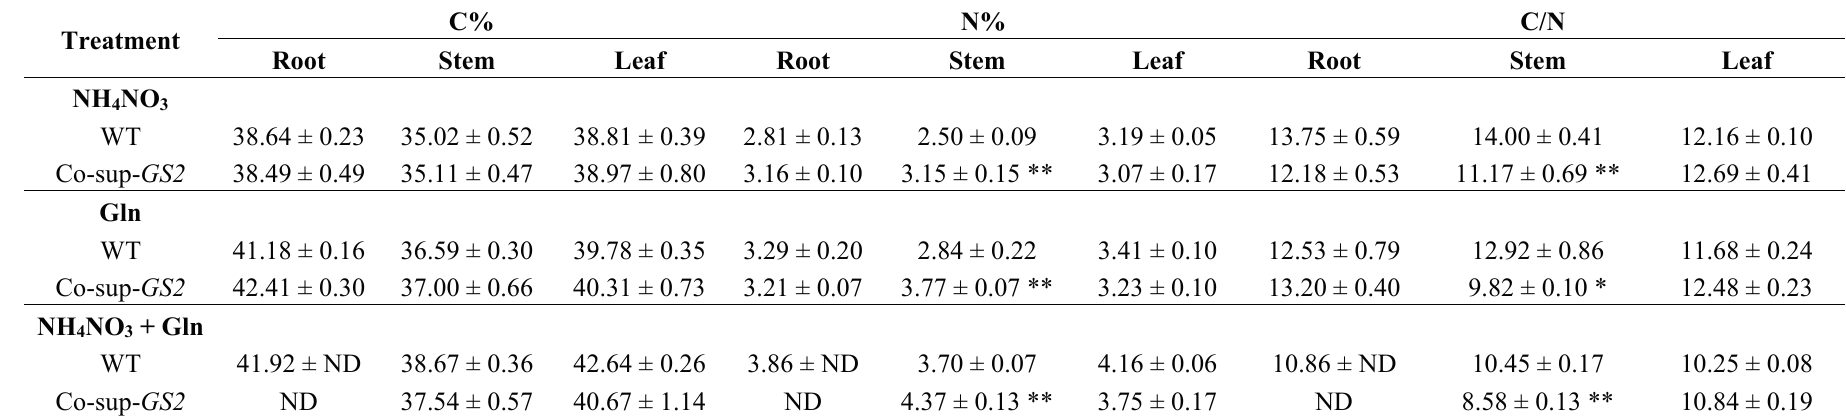
Table 2. The carbon content (C%), nitrogen content (N%) and carbon/nitrogen ratio (C/N) in the roots, stems and uppermost leaves of the GS2 -cosuppressed plants (Co-sup- GS2 ) and wild-type plants (WT) at the tillering stage under N (NH 4 NO 3 ), G (Gln) and N + G (NH 4 NO 3 + Gln)